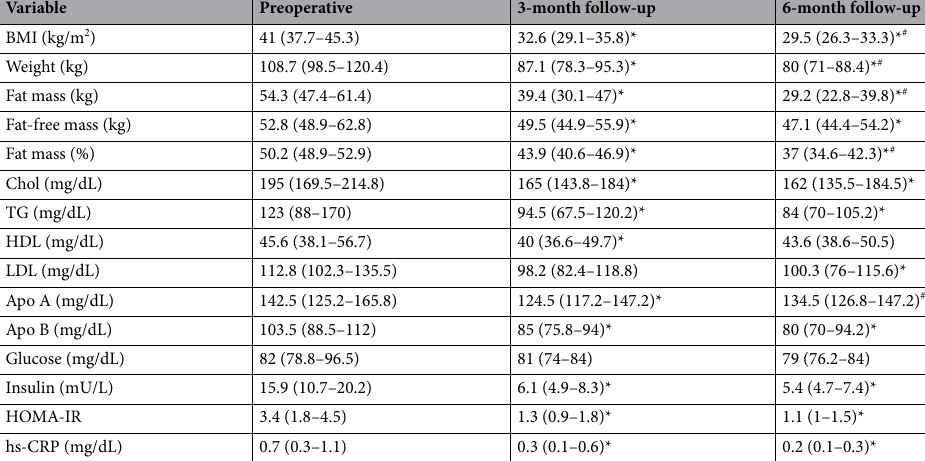
Table 2. Anthropometric measurements, body composition, and biochemical parameters of the patients before and after bariatric surgery. n = 32. Data summarized as median (IQR), Apo: Apolipoprotein, BMI: Body Mass Index, HDL-c: High Density Lipoprotein Cholesterol, HOMA-IR: Homeostatic Model Assessment for Insulin Resistance, IQR: Interquartile Range, LDL-c: Low Density Lipoprotein Cholesterol, hs-CRP: high test with post-hoc pairwise Nemenyi